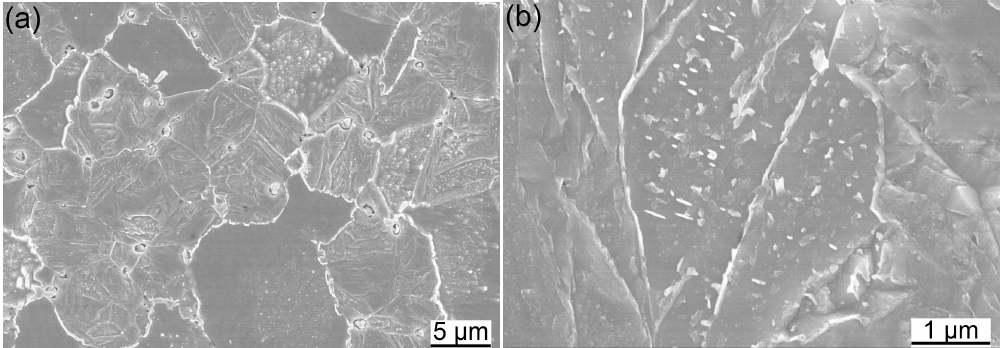
Figure 5. OM images of polished and etched samples: ( a ) MP; ( b ) MX; ( c ) ODS.